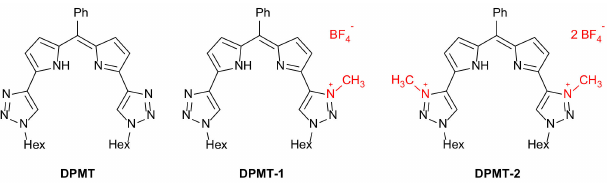
Figure 1. Examples of some dipyrrins involved in anion binding.